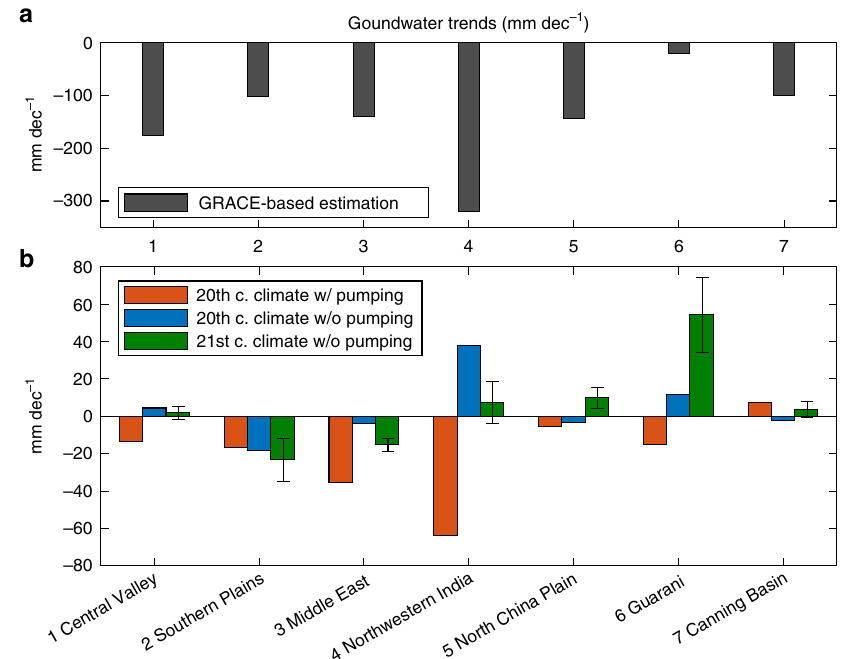
Fig. 4 Trends of GWS. a GRACE-based estimates (i.e., GRACE minus GLDAS) of GWS trends (2003 − 2014). b The twentieth-century GWS trends with pumping are estimated based on CESM simulations (1900 − 1999) in our previous study 40 . The twentieth and twenty- fi rst-century GWS trends without pumping are estimated based on the CESM-LE simulation during 1900 − 1999 and during 2006 − 2100, respectively. The error bars represent the spread of one standard deviation among 30 ensemble